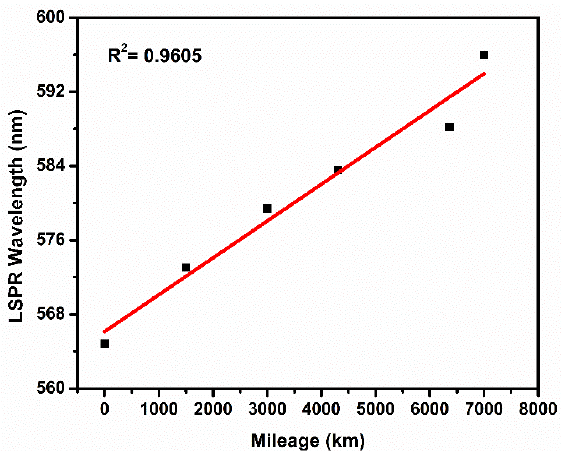
Figure 9. Displacement of the LSPR band position with mileage. Red line represents a linear fit of the experimental data.